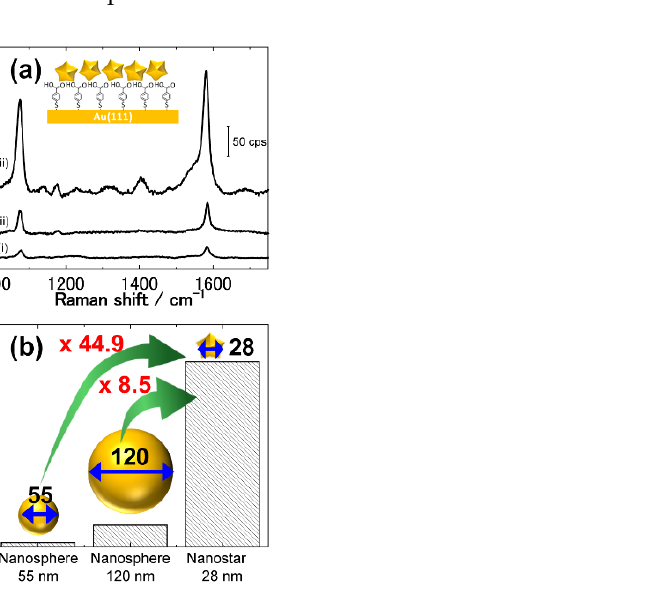
Figure 3. Enhancement effect of shell-isolated Au nano-structured amplifiers. ( a ) Raman spectra of mercaptobenzoic acid self-assembled monolayer (MBA-SAM) on Au(111) enhanced by (i) 55 nm Au nano-spheres, (ii) 120 nm Au nano-spheres and (iii) 28 nm Au nanostars. The excitation wavelength was 632.8 nm. ( b ) Comparison of Raman signal intensities of MBA-SAM on Au(111) with different optical amplifiers calculated for the peak intensity at 1583 cm − 1 which was assigned to the ring breathing